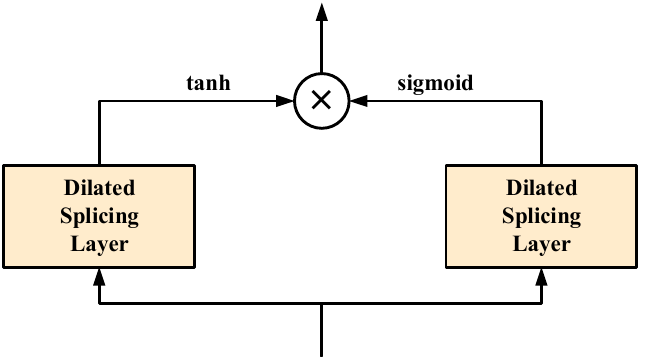
Figure 4. Temporal convolution module structure.